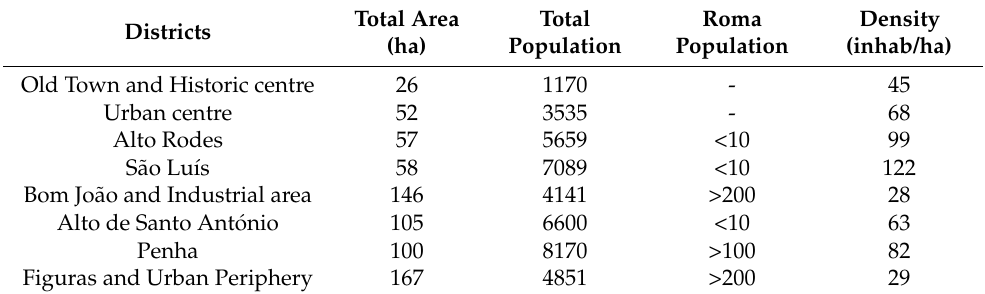
Figuras and Urban Periphery Table 4 for Tartu and Table 5 for Faro show the results of availability and accessibility to PGS of